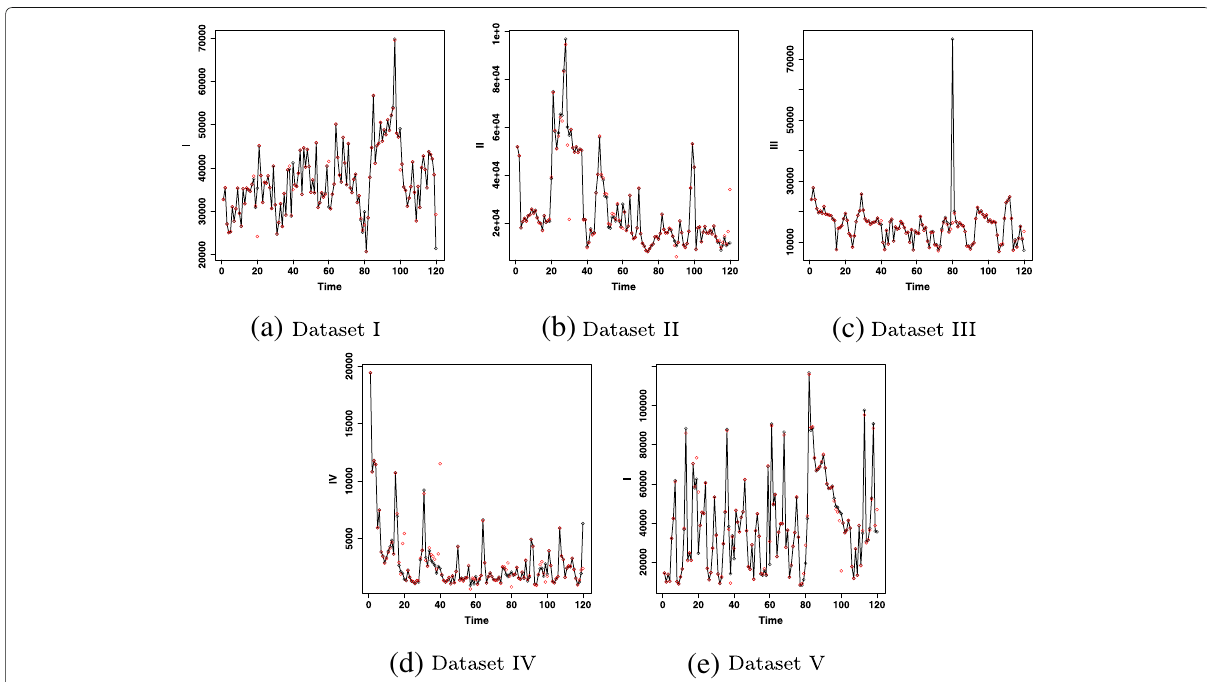
Fig. 5 Prediction accuracy of BRNN-LSTM (black line: observed values; red circles: predicted